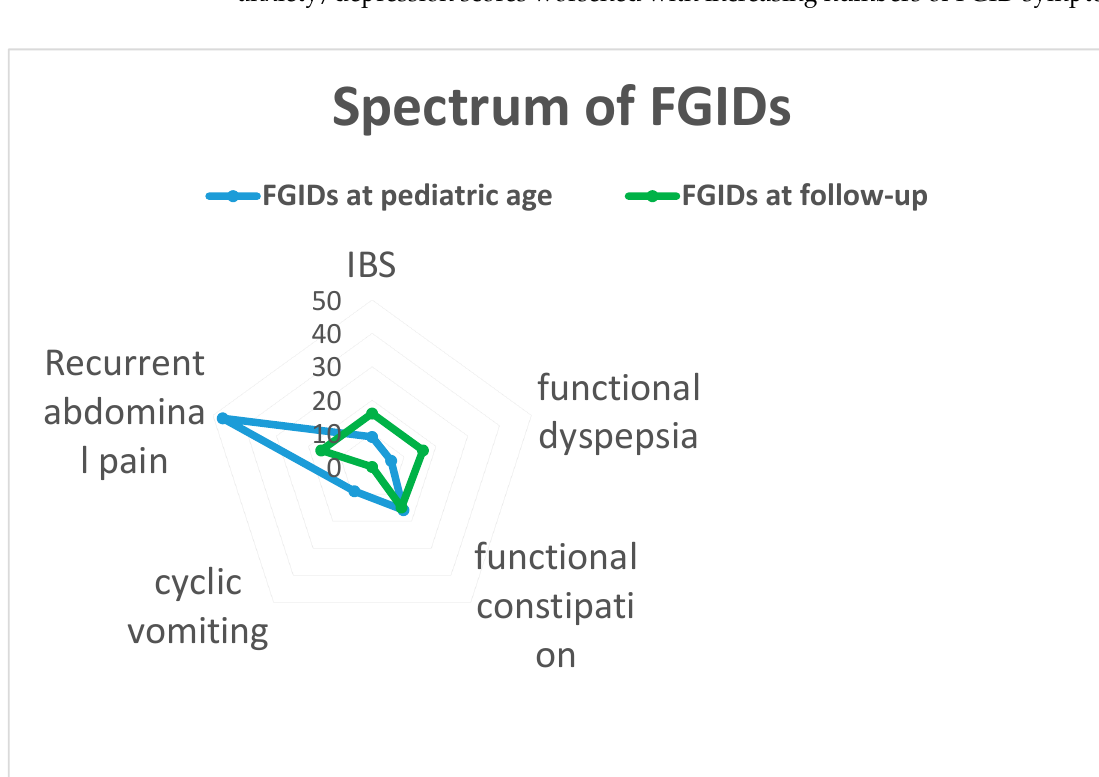
Figure 1. The figure shows the distribution of all subtypes of FGIDs during childhood (blue line) and adulthood (green line), representing their evolution over time. The most frequent FGID type in childhood is recurrent abdominal pain. Otherwise, in the young adult population dyspepsia, IBS, functional constipation and recurrent abdominal pain are equally represented, while cyclic vomiting seems to disappear.